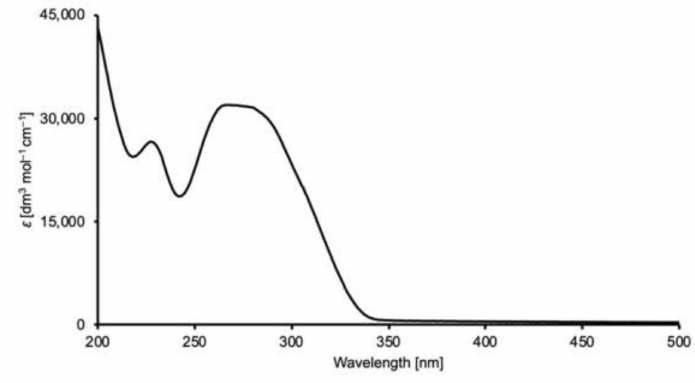
Figure 2. The solution absorption spectrum of compound 3 (MeCN, 2 × 10 − 3 mol dm − 3